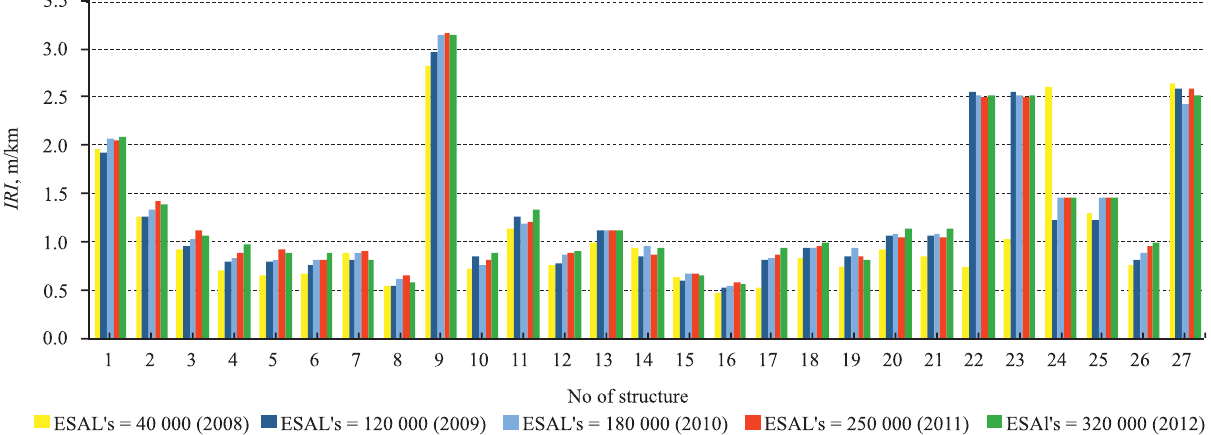
Fig. 7. Distribution of roughness in different pavement structures depending on the number of ESAL’s 100